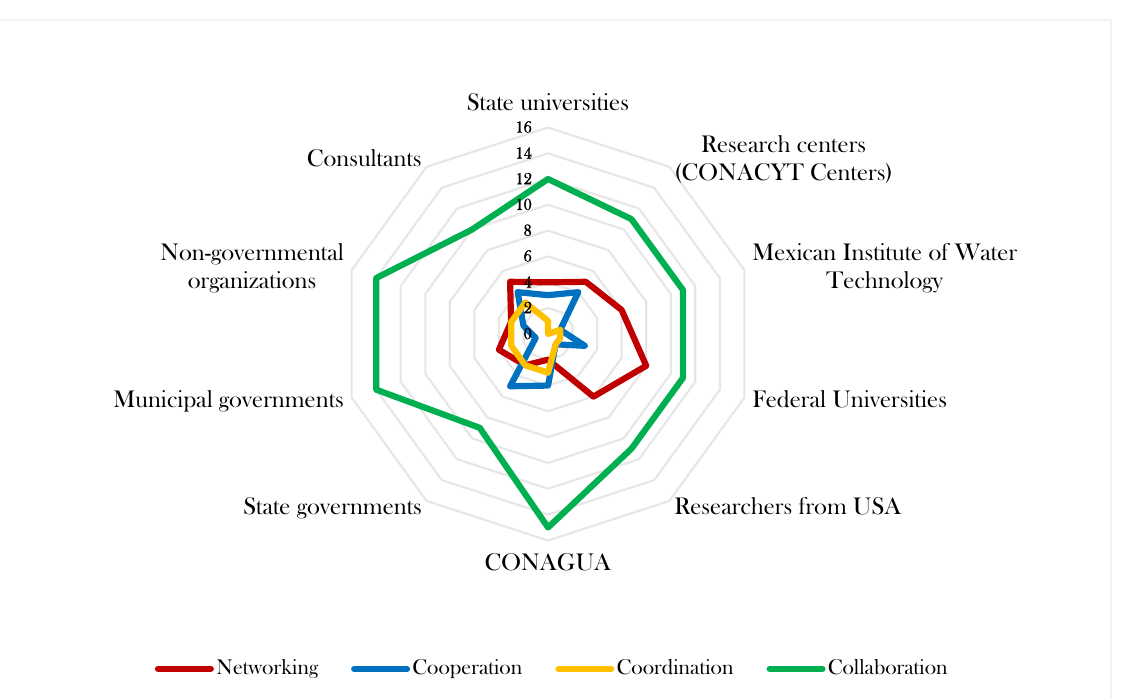
Figure 2 . Representation of the interactions that participants identified maintained when conducting water recharge projects. Colored lines represent the type of interactions, networking (red), cooperation (blue), coordination (yellow), and collaboration (green); the numbers represent the frequency that participants selected that type of interaction.